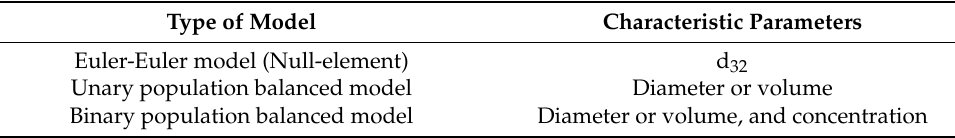
Table 2. The characteristic parameters of PBM